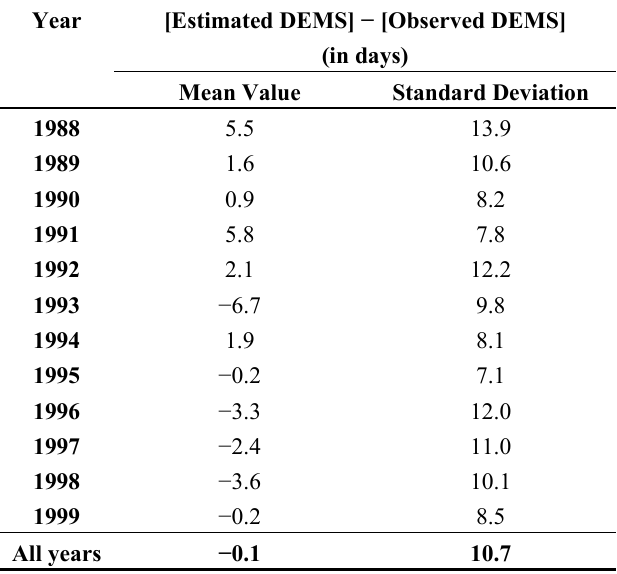
Table 7. Statistics on the difference between the date of the end of the melt season (DEMS), as estimated from satellite imagery using the merging algorithm, and that calculated from snow depth observations at the 20 meteorological